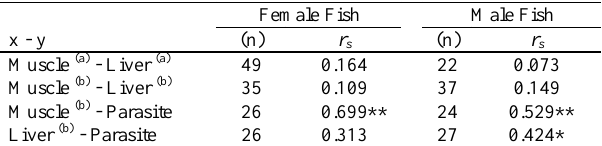
Table 5 . Spearman correlation coefficient ( r significance of the relationship between the total concentrations of mercury (ng.g -1 ) in the tissues of fish and between concentrations in the tissues of fish and in the parasites, from the middle Itabapoana River, Brazil. (a) Data from non-infested fish. (b) Data from infested fish. (* P < 0.05; ** P